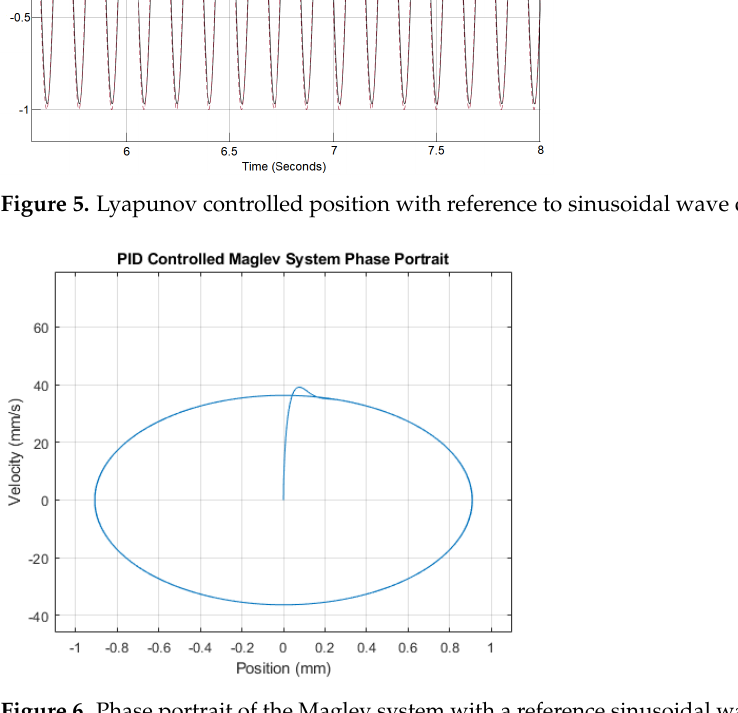
Figure 6. Phase portrait of the Maglev system with a reference sinusoidal wave of 40 rad/s frequency under PID control.